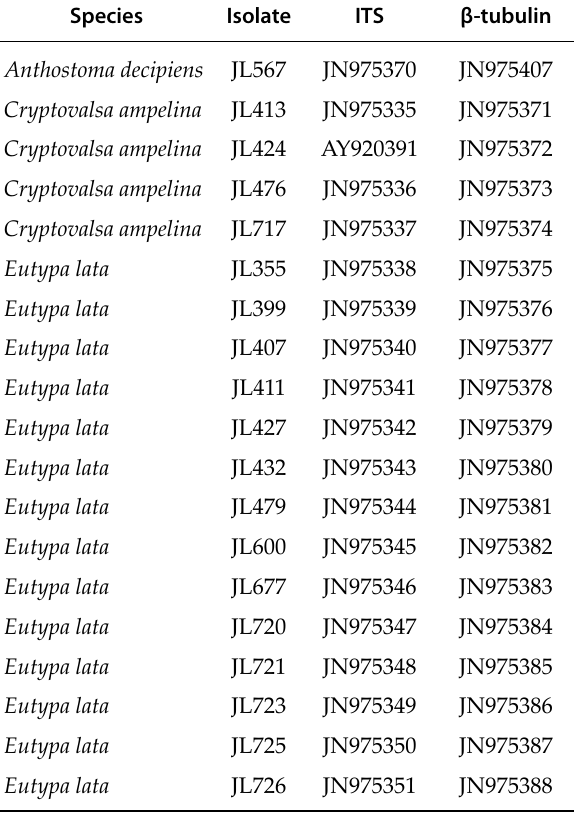
Table 2. Nucleotide sequences of the Spanish isolates of Diatrypaceae deposited in GenBank. Species Isolate